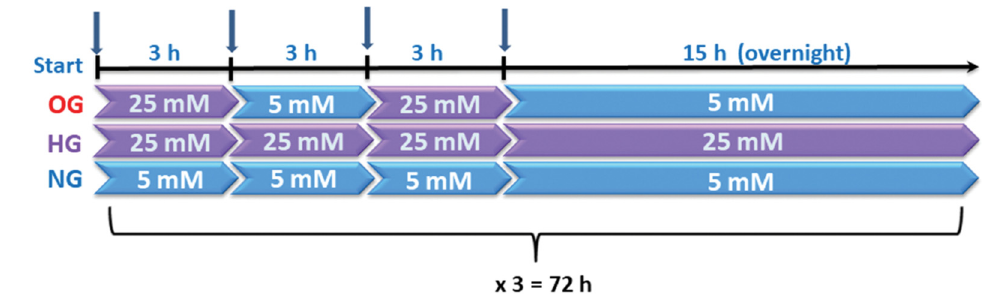
Figure 1. Graphical representation of the experimental design. Cells were exposed to 5 mM glucose (NG), 25 mM glucose (HG) or alternatively to 5 mM/25 mM glucose (OG) at every 3 h, for 72 h. For osmotic control, the cells from EA.hy926 line were incubated with L-glucose or mannitol using the same protocol for OG. To investigate the mechanisms by which OG induce EC dysfunction, in some experiments, NAC (7.5 mM) or Bay (15 µ M) were added to the OG experimental condition, for the whole period of